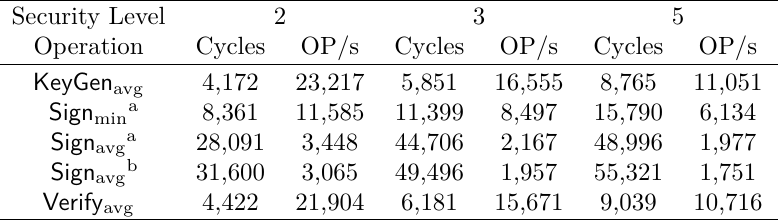
Table 4: Performance